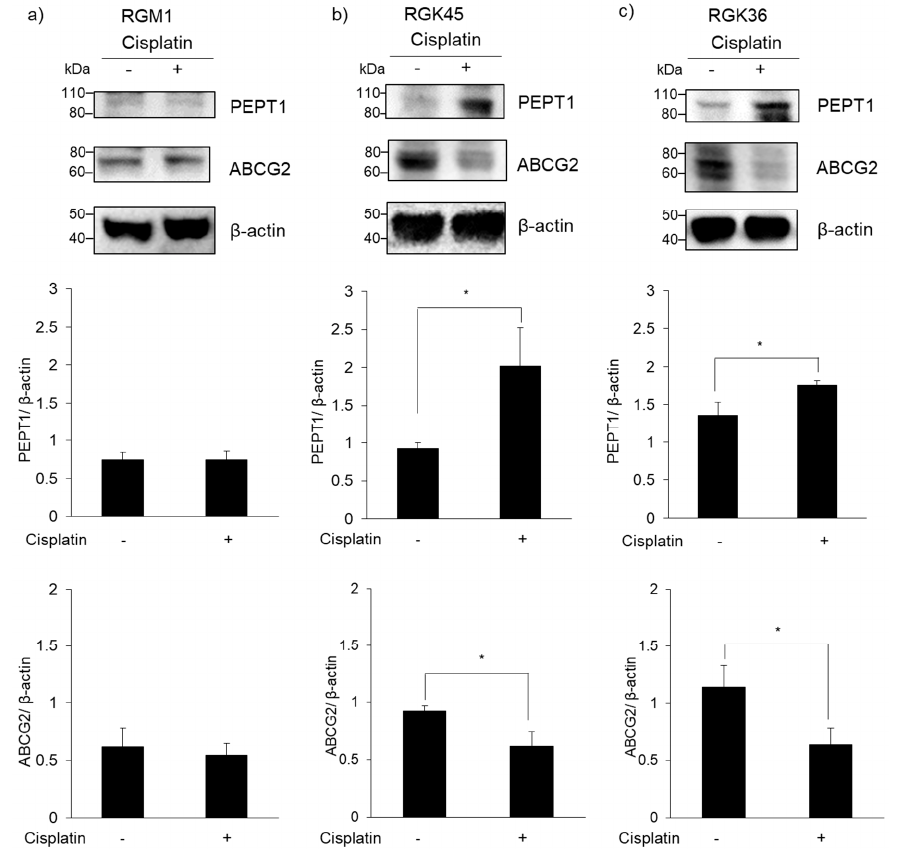
Figure 4. Expression of peptide transporter 1 (PEPT1) and ABCG2. ( a ) RGM1, ( b ) RGK45 and ( c ) RGK36. PEPT1 and ABCG2 expressions in RGK45 and RGK36 cells were changed by cisplatin treatment (10 μ M). Data are expressed as the mean ± SD (n = 3). * p < 0.05.